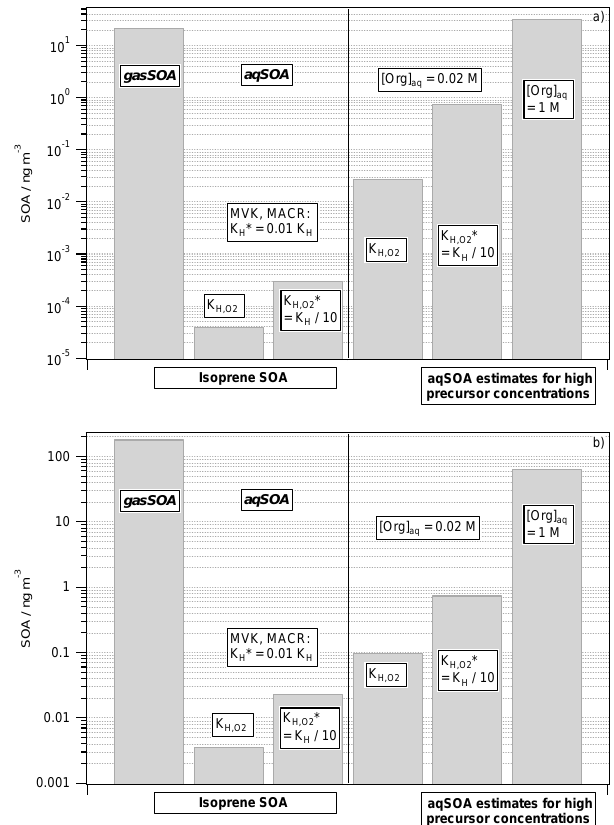
Figure 8. Comparison of aqSOA and gasSOA formation after (a) 2h and (b) 6h. The first three bars show predicted SOA from isoprene. The last three bars show predicted aqSOA mass for as- sumed oligomer precursor concentrations of 0.02M (high and low O 2 solubility) and 1M in aerosol water,